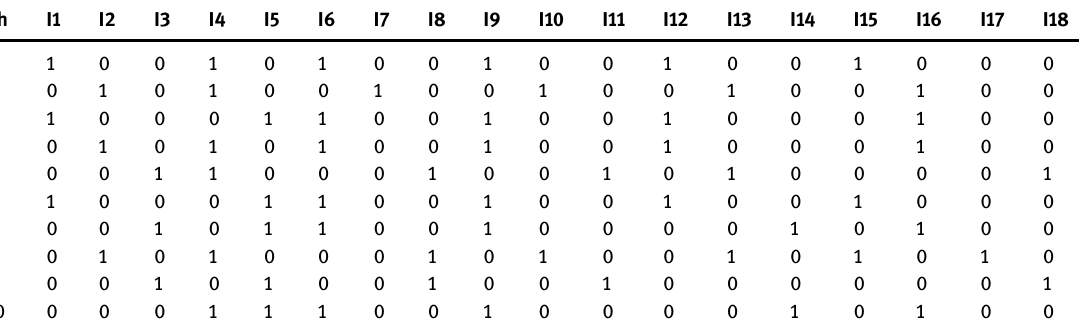
Table 3: Data converted to